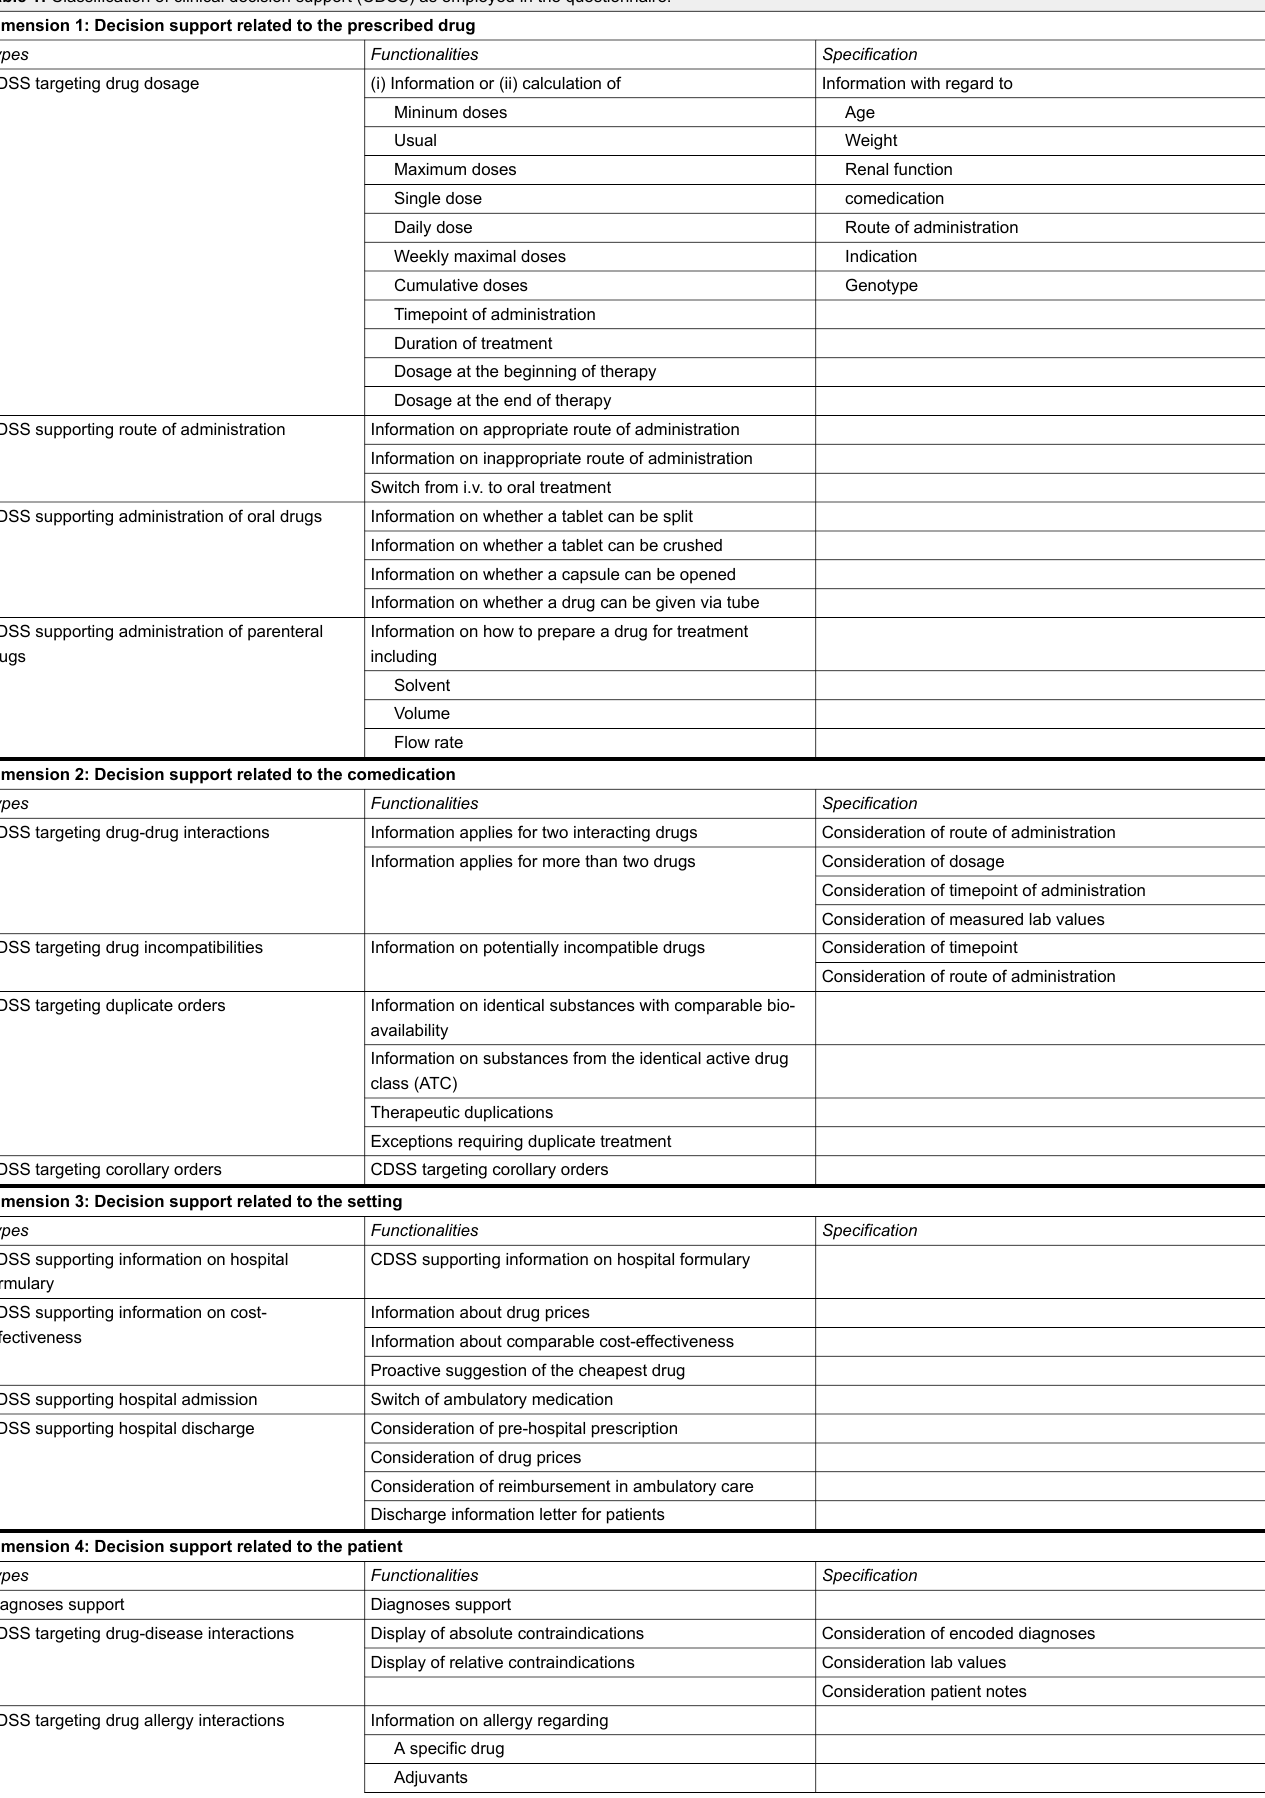
Table 1: Classification of clinical decision support (CDSS) as employed in the questionnaire. Dimension 1: Decision support related to the prescribed